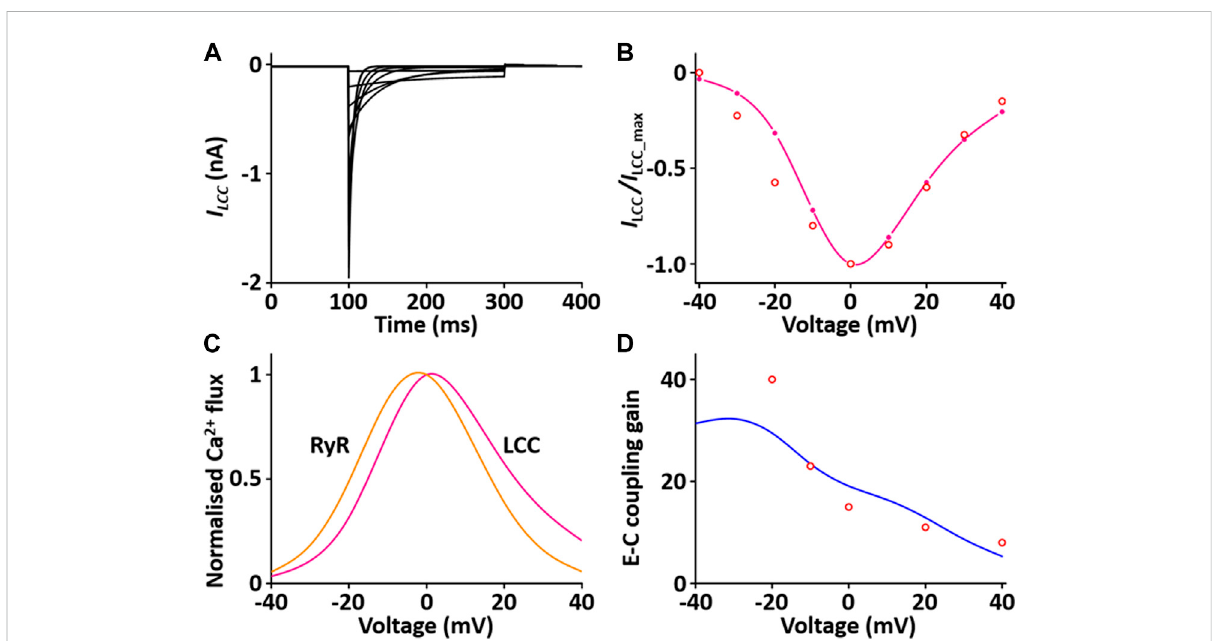
FIGURE 6 Veri fi cation of I LCC and I RYR implementation (Kim, 2018). (A) Simulated current traces for the LCC by a voltage step from − 40 to 40 mV from a holding potential of − 50 mV. (B) Normalized simulated I-V relationship for I LCC (pink line). This simulated result is in close agreement with representative experimental result (o, Zahradnikova et al. (Zahradnikova et al., 2004)). (C) Simulated peak fl uxes of LCC (pink line) and RYR (yellow line) as a function of membrane voltage. (D) Simulated EC coupling gain (blue line, maximum of RYR fl ux/maximum LCC fl ux) is in close agreement with representative experimental result (o, Wier at al. (Wier et al., 1994)).